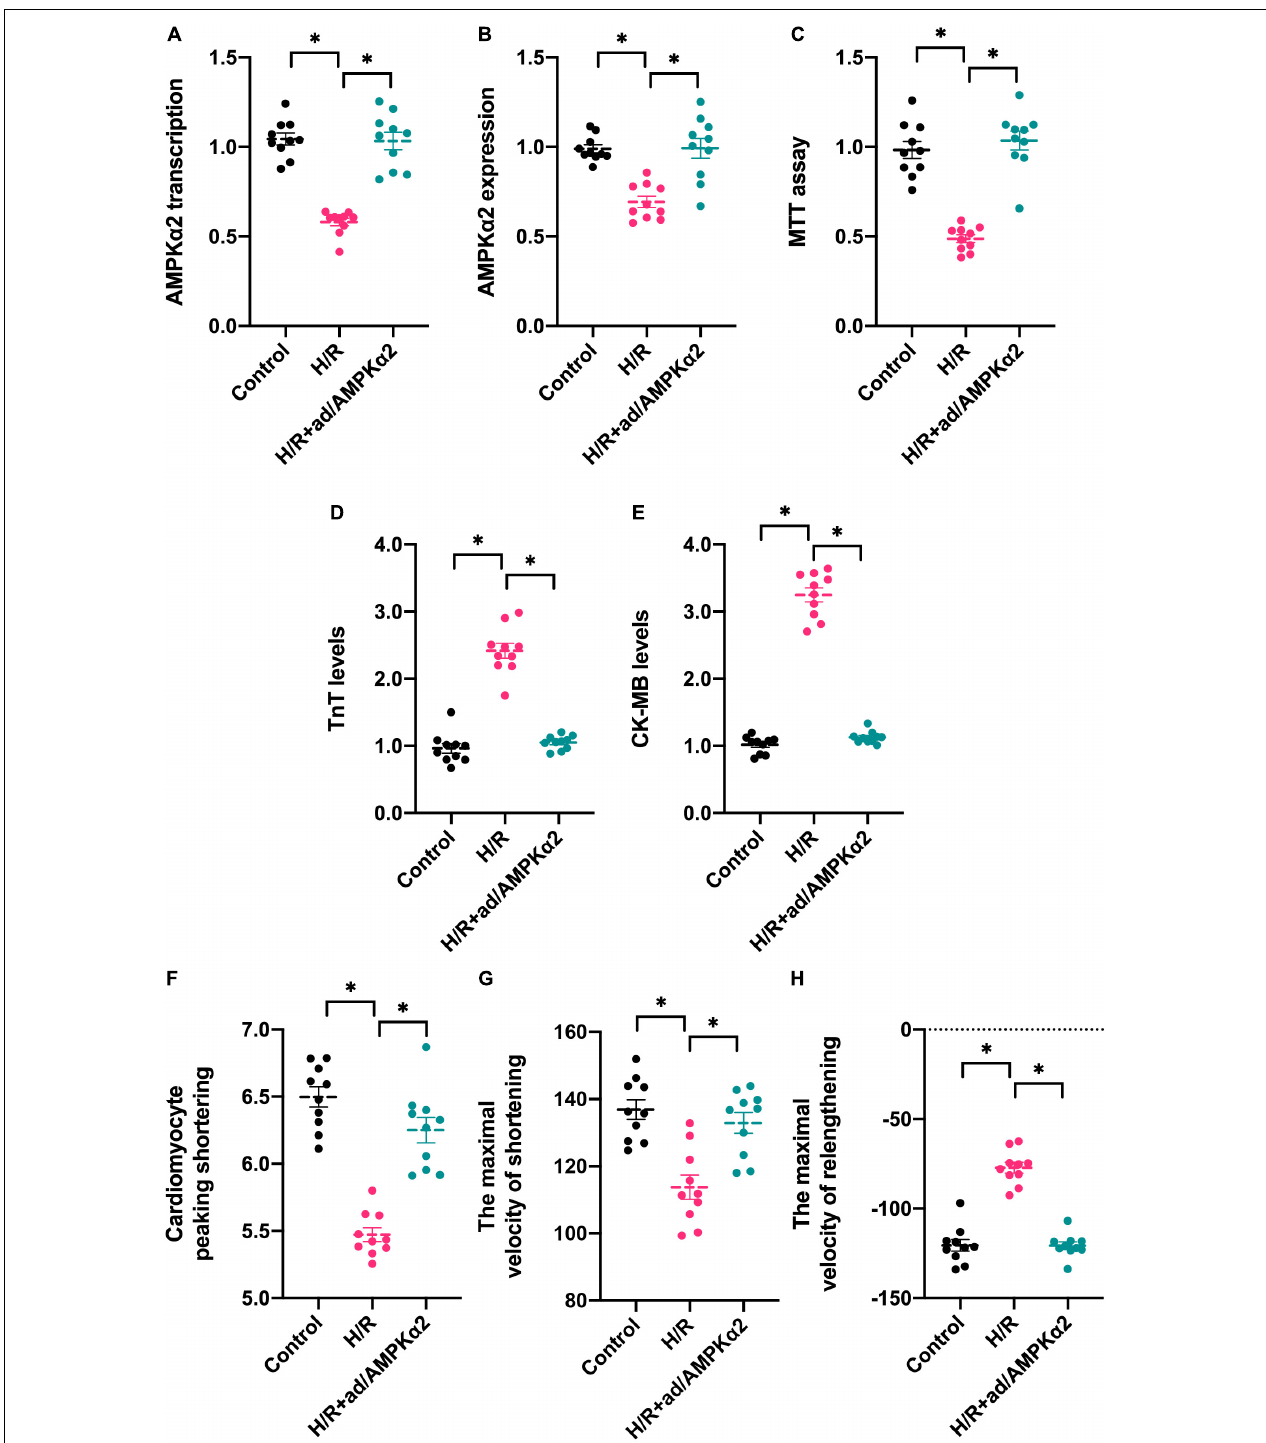
FIGURE 1 | AMPK2 α overexpression attenuates hypoxia/reoxygenation-mediated cardiomyocyte dysfunction and apoptosis. Adenovirus loaded with AMPK α 2 were transfected into cardiomyocytes before H/R injury. (A) H/R injury was established through 1-h hypoxia, 2-h reoxygenation RNA was isolated from cardiomyocyte, and qPCR was used to evaluate the transcription of AMPK α 2. (B) Proteins were collected from H/R-treated cardiomyocytes, and then, the expression of AMPK α 2 was determined through western blots. (C) MTT assay was used to evaluate cell viability in response to H/R injury. (D,E) ELISA assay was used to measure the levels of troponin T (TnT) and creatine kinase-MB (CK-MB) in H/R-treated cardiomyocytes. (F–H) The cardiomyocytes contractile properties in the context of HI/R injury. The data represent the mean ± SEM. P < 0.05.